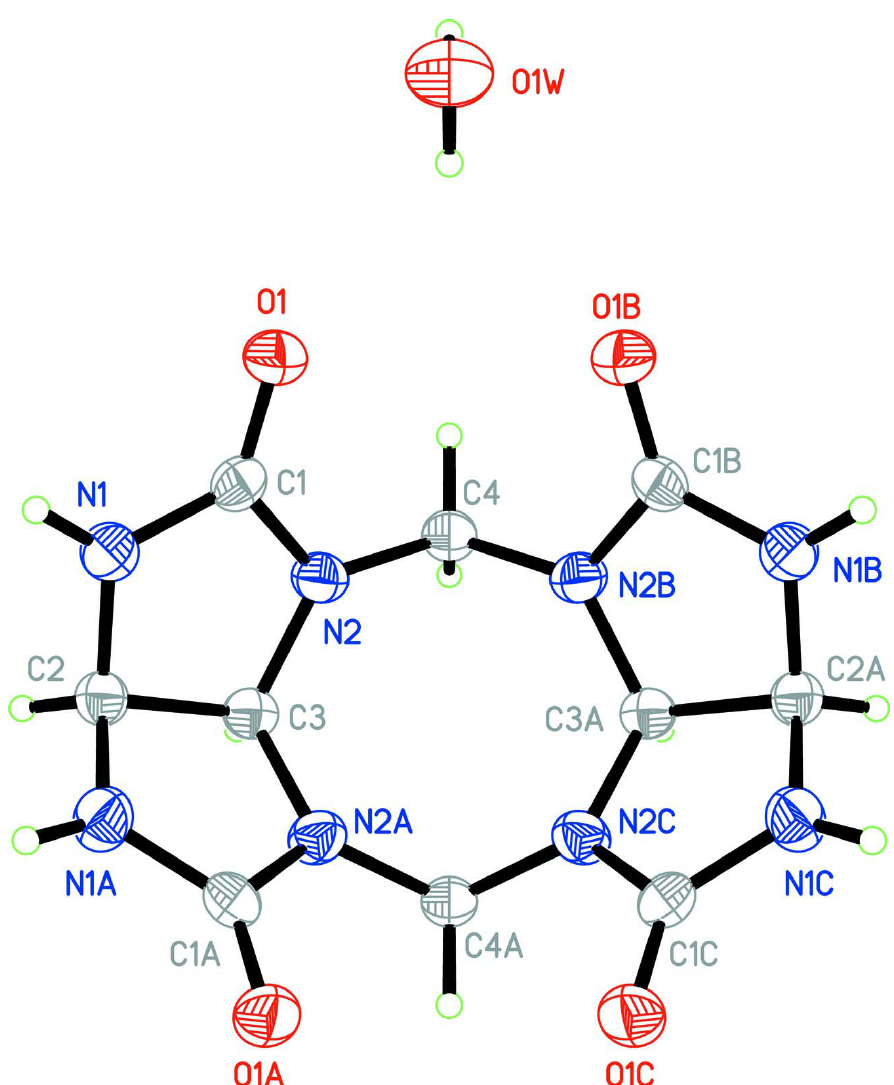
The molecular structure of (I) showing the atom-labelling scheme (Symmetry codes: (A) - x + 3/2, y , z , (B) x , - y + 3/2, z , (C) - x + 3/2, - y + 3/2, z ,). Displacement ellipsoids are drawn at the 50% probability